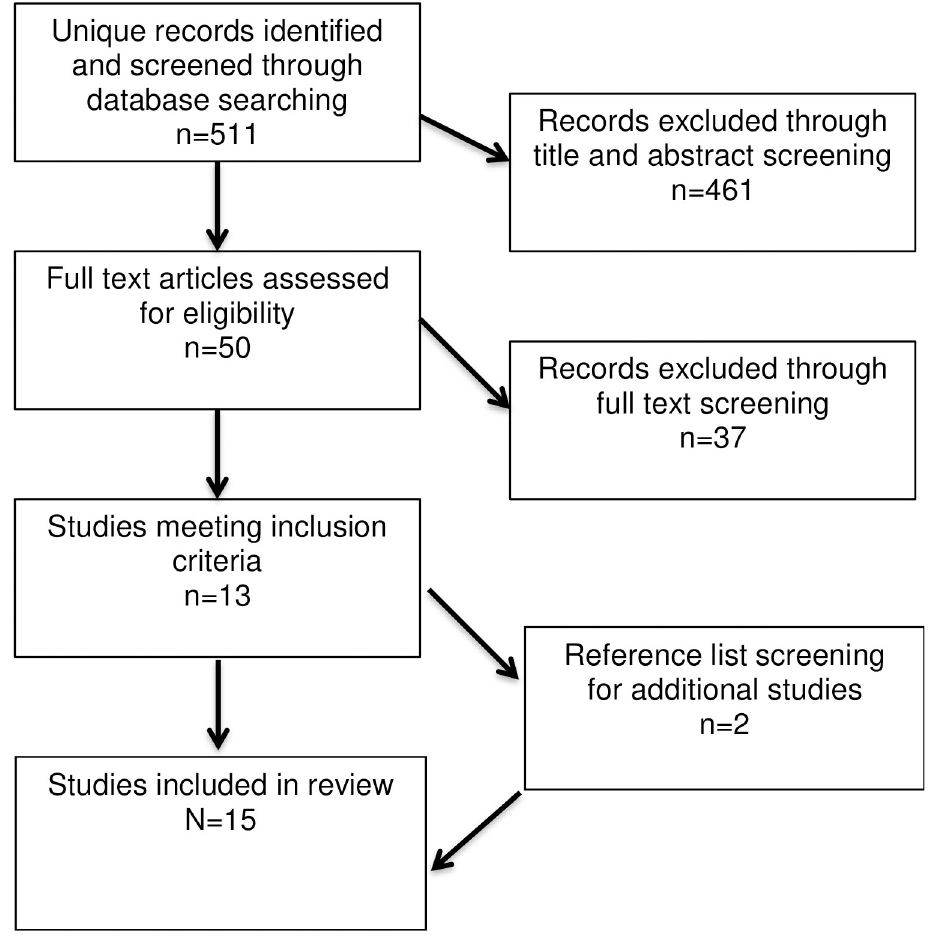
Fig 1. Eligibility flow